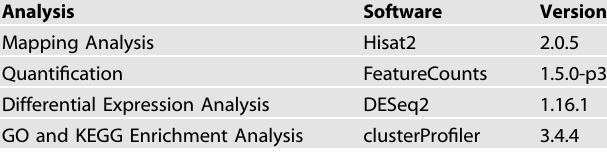
Table 2. Software used in the clean data analyses.